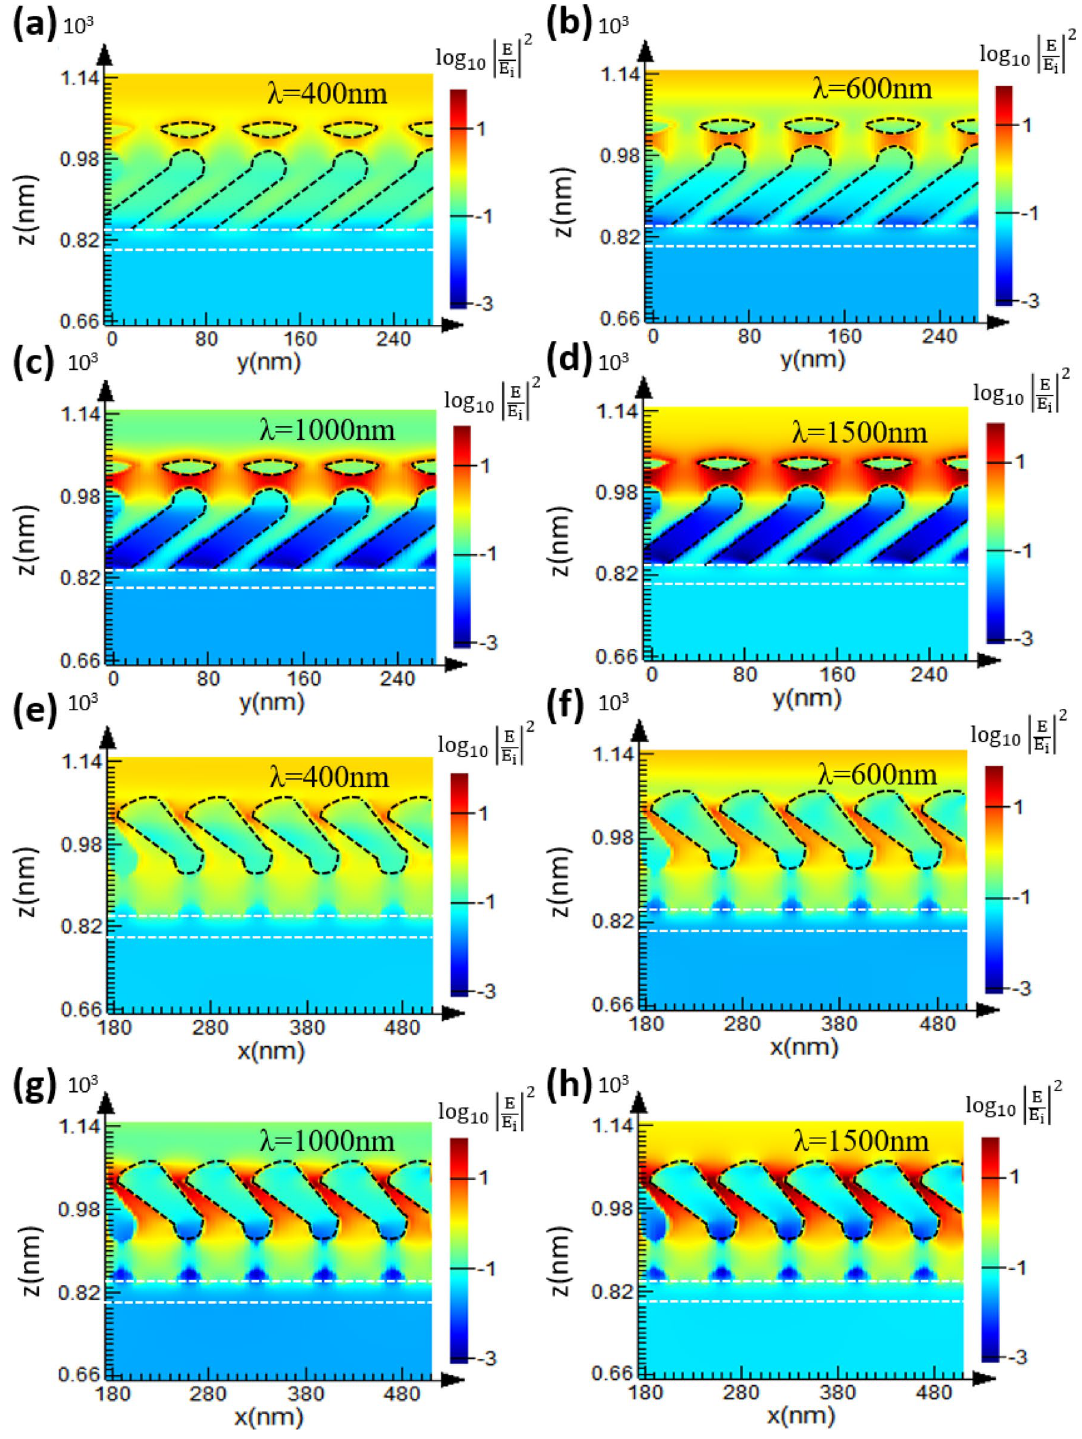
Figure 9. ( a – d ) Electric field intensity distributions for the y–z plane across the center of bottom rods; ( e – h ) electric field intensity distributions for the x–z plane across the center of upper